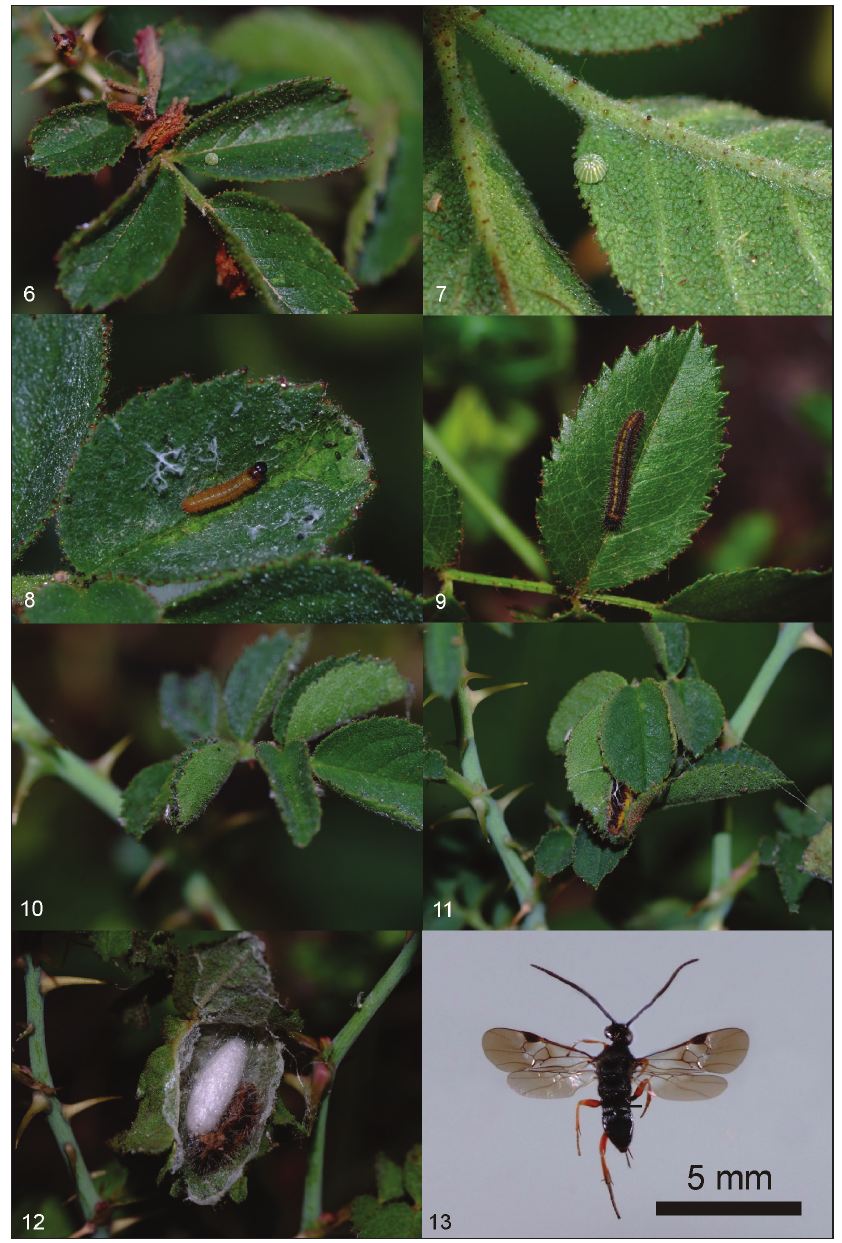
Figures 6–13. Life cycle of Spialia rosae on Rosa sicula in Puerto de la Ragua, Granada, SE Spain. 6. Egg on the upperside of a leaf of R. sicula and 7. On the underside of the leaf (July 2012). 8. Recently emerged first instar larva on a leaf of R. sicula (note that the epidermis and parenchyma of the leaf have been eaten, July 2012). 9. Third instar larva. 10, 11. Larval shelter made with leaves. 12. Cocoon of the parasitoid Microgaster australis (Hymenoptera), with the remains of a third instar larva of S. rosae on R. sicula . 13. Adult of M. australis bred from S. rosae . Photographs 9–13 were taken in August